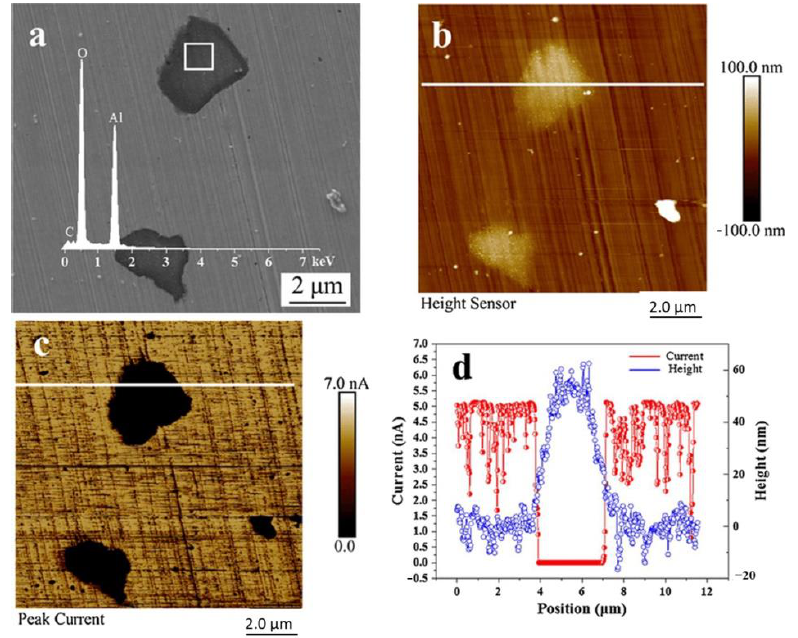
Figure 3. ( a ) SEM and EDS results of inclusions; ( b ) AFM terrain of the same area as ( a ); ( c ) con- ductivity map of the same area as ( a ); ( d ) line scan analysis results in ( b , c ) [13]. Reproduced with permission of Elsevier, copyright 2018.